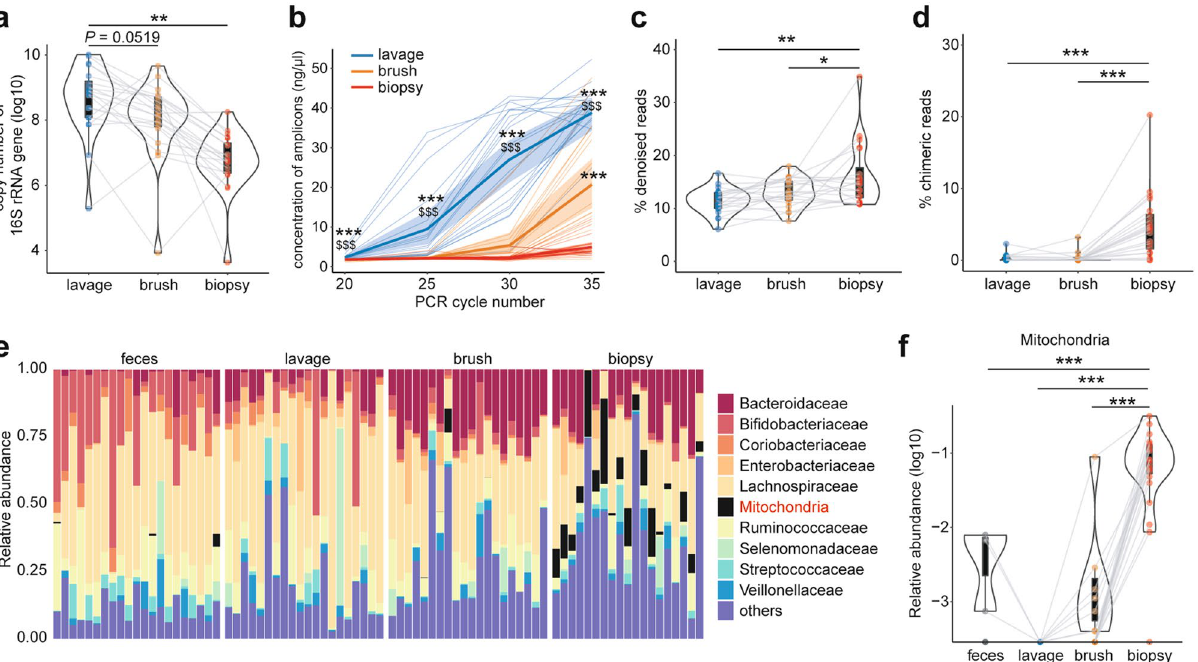
Figure 1. Quality of sequencing data from mucosal samples. ( a ) Bacterial loads in mucosal samples as assessed by qPCR of 16S rRNA genes. ( b ) Concentration of PCR amplicons for 16S rRNA gene sequencing at indicated cycle numbers. The values were calculated per ml for lavage and per sample for brush and biopsy. ( c , d ) Percentage of denoised reads as low-quality ( c ) and chimeric reads ( d ), detected and eliminated through the DADA2 pipeline (see Supplementary file: Fig. S1D). ( e ) Barplot representing the top 10 most abundant families and the remainder labeled “others” in feces and mucosal samples. ( f ) Relative abundance of